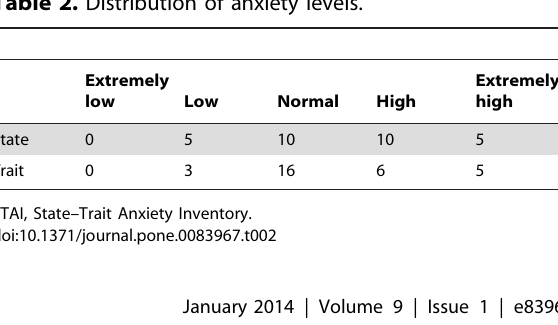
Table 2. Distribution of anxiety